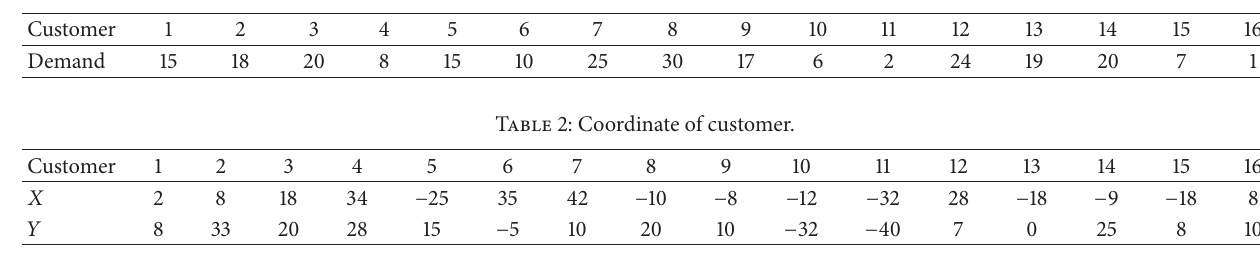
Table 1: Demand of customer.